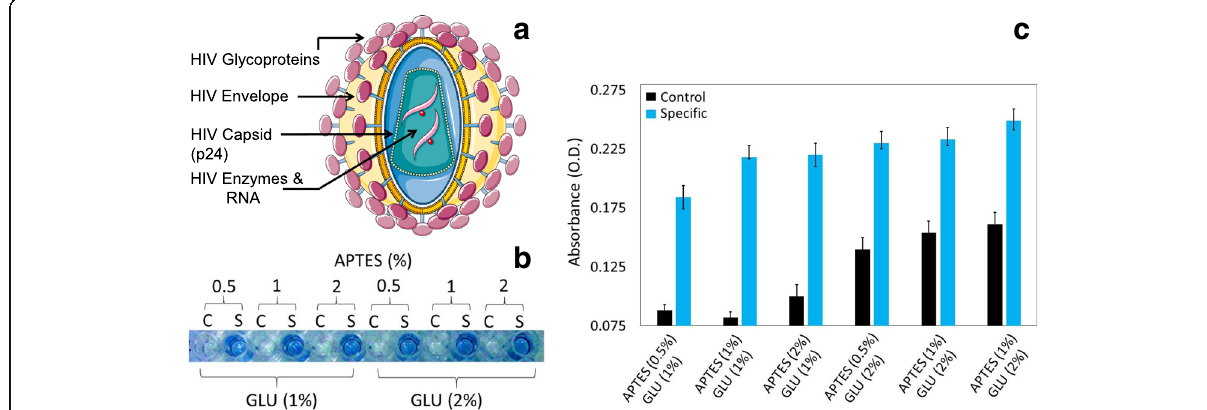
Fig. 3 a Intact HIV structure. The p24 antigen is indicated. b The optimization of APTES and GLU. APTES (0.5, 1, and 2%) and GLU (1 and 2%) were used with different combinations to detect the constant concentration (250nM) of HIV-p24